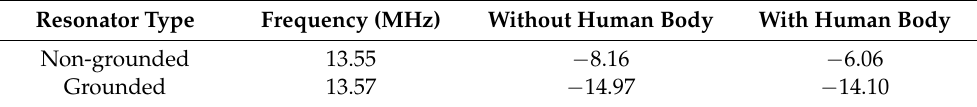
Table 1. S 11 (dB) of the two WPT systems with and without a human-body model at resonant frequency.